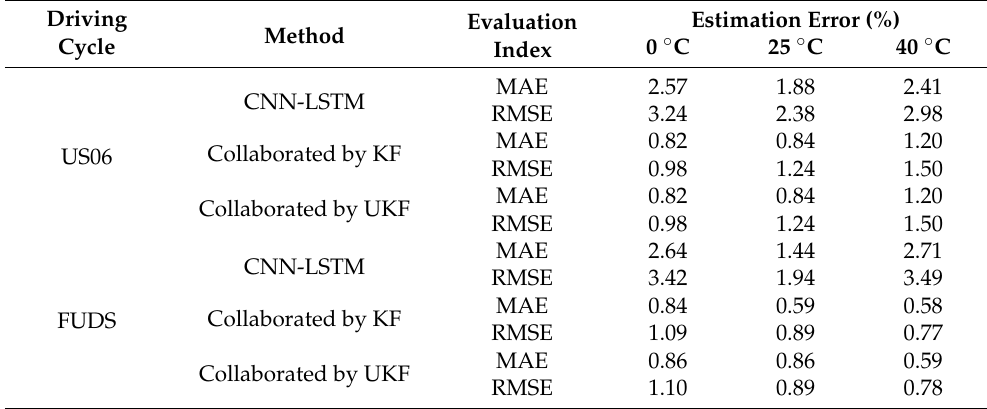
Table 2. RMSEs and MAEs of SOC estimation results with CNN-LSTM and end-cloud collaboration system under different